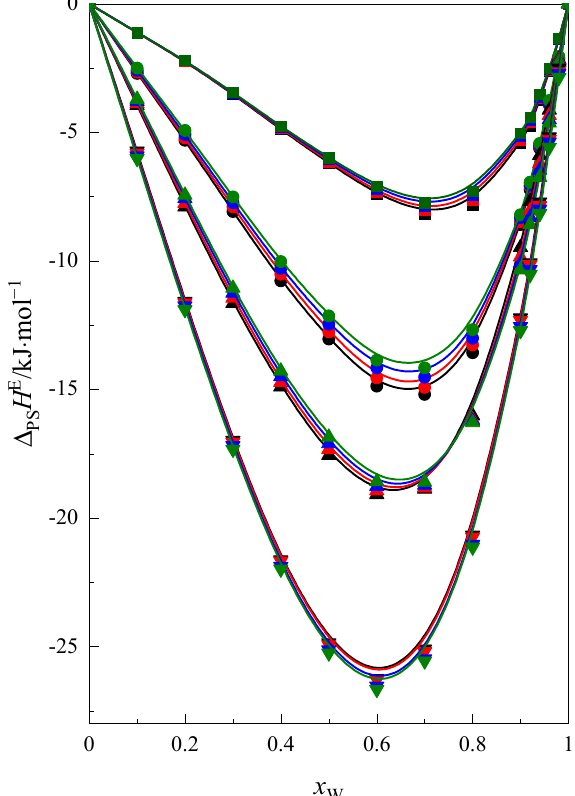
Figure 4. The enthalpic effect of the preferential solvation of cyclic ethers: 1,4-dioxane, (cid:4) [16]; 12C4 ● [16]; 15C5, ▲ ; and 18C6, ▼ in the F + W mixture at: 293.15 K (black line), 298.15 K (red line), 303.15 K (blue line), 308.15 K (green line).